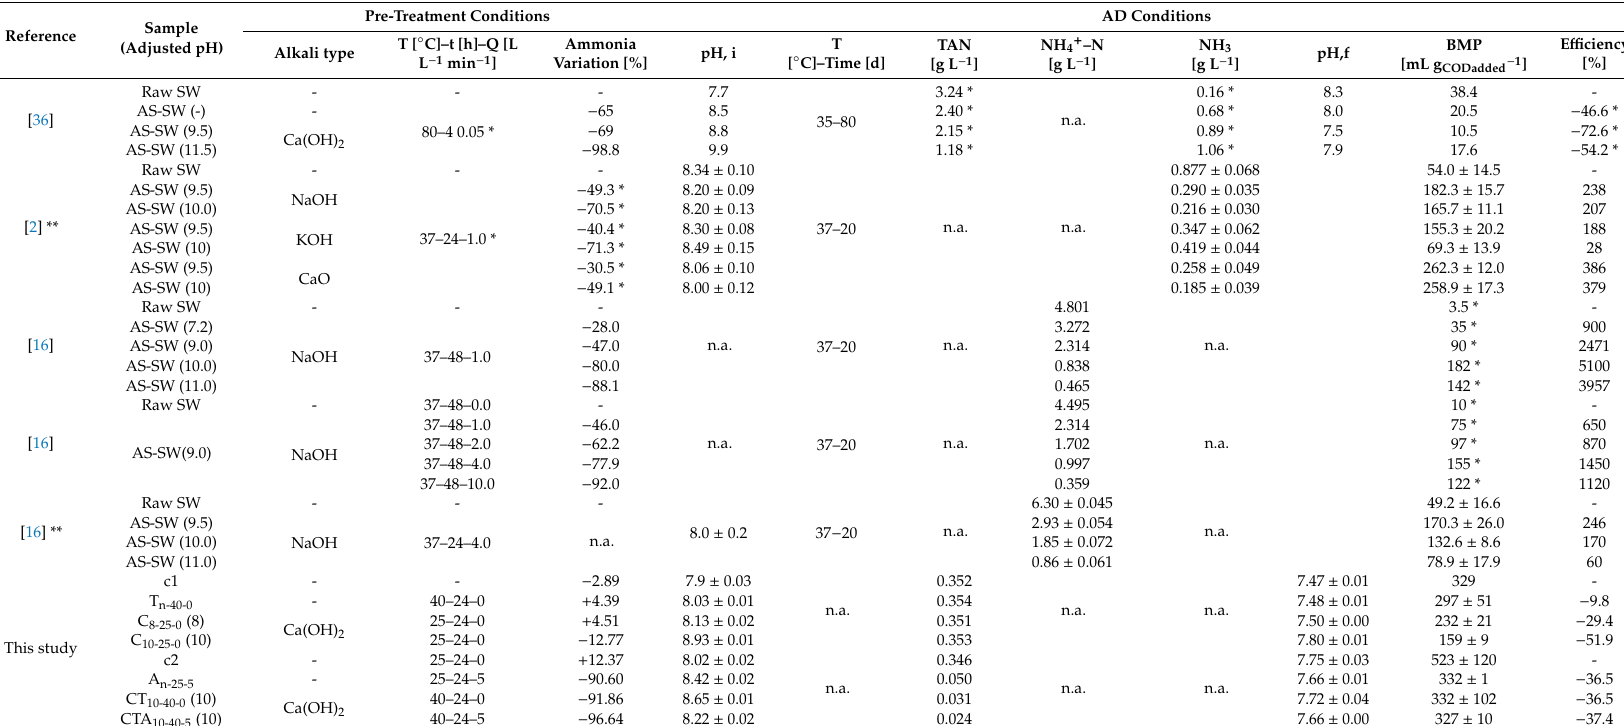
Table 6. Pretreatment conditions and AD performances obtained in this study and comparison with other